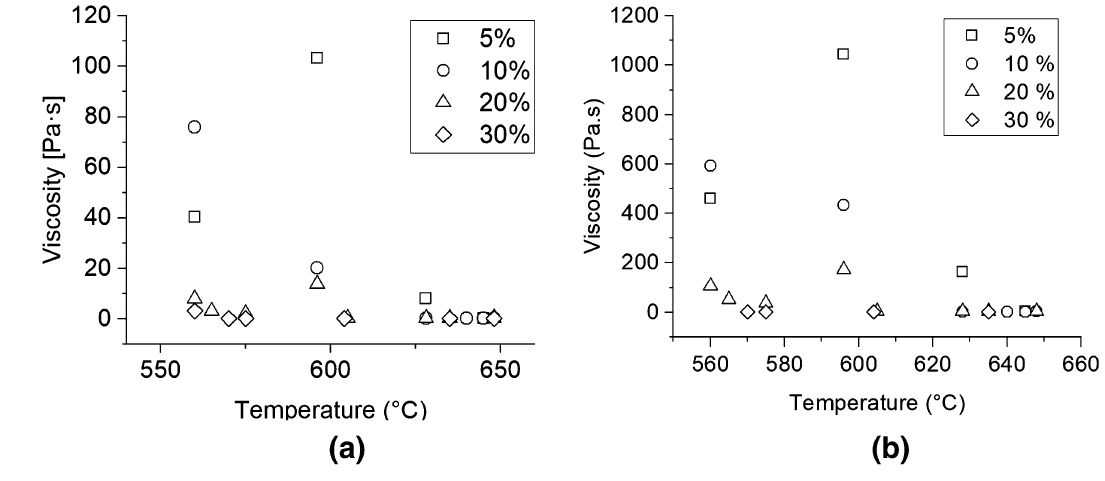
Fig. 3 Rotational viscosity measurements at a shear rate of a 10 s −1 and b 1 s −1 for 5, 10, 20 and 30% Cu (by weight) in Al